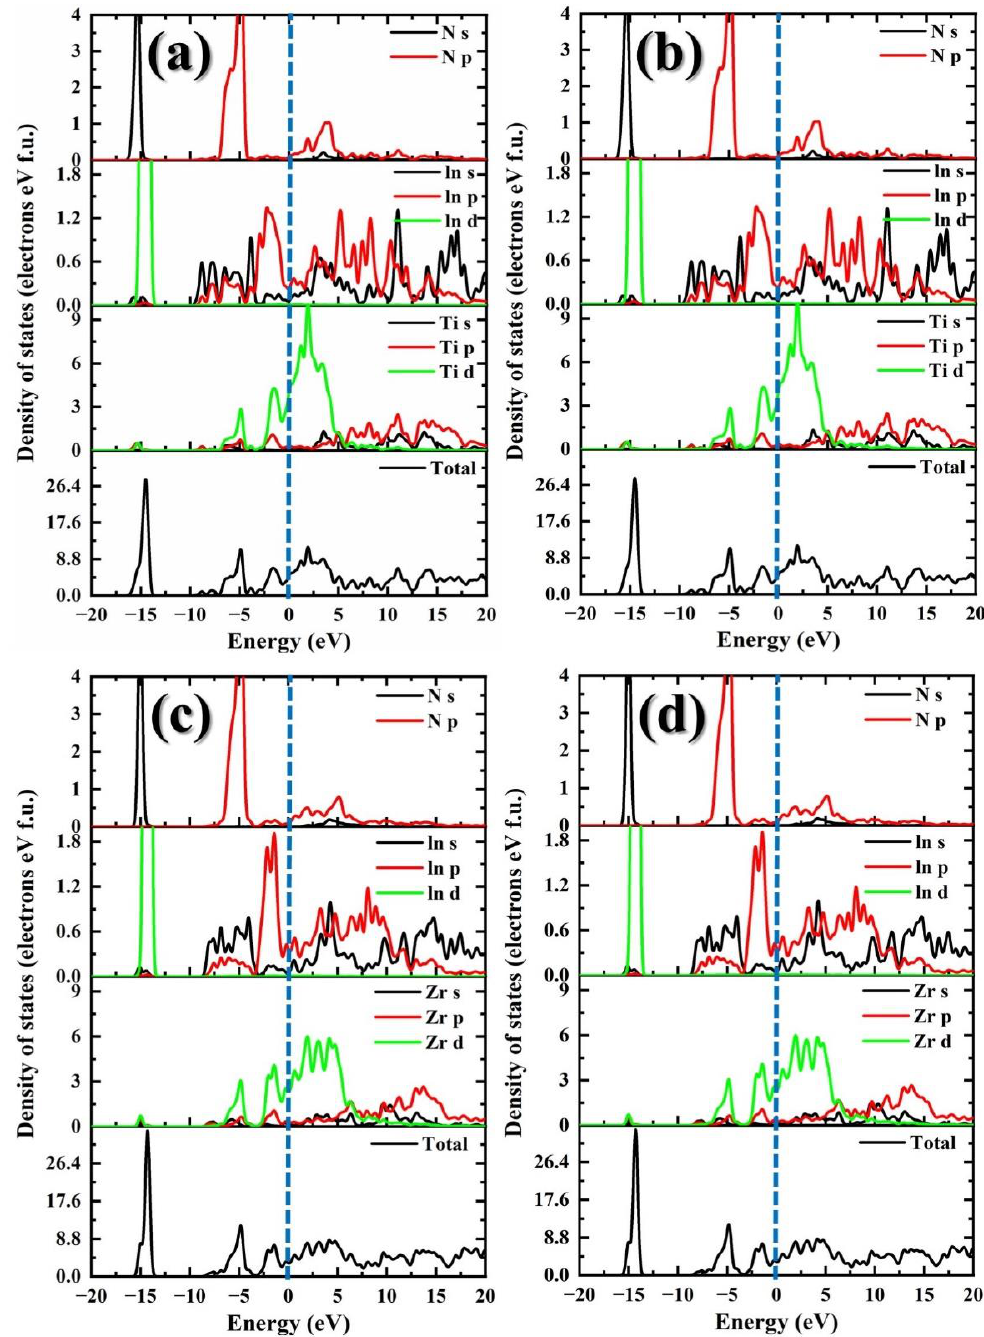
Figure 11. The calculated total and partial density of states for ( a ) Ti 2 InC, ( b ) Ti 2 InN, ( c ) Zr 2 InC, and ( d ) Zr 2 InN.